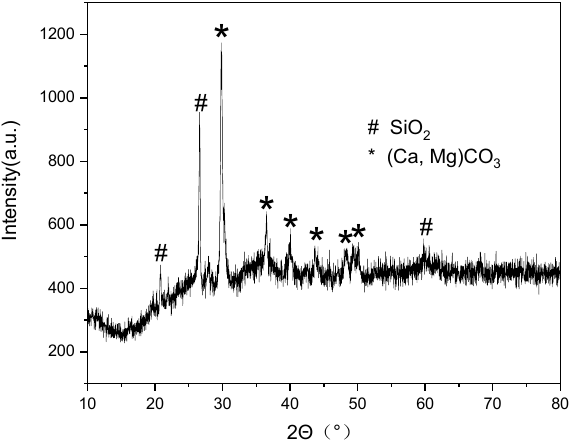
Figure 13. XRD diagram of dark coagula on the outer surface of sample DL-1.